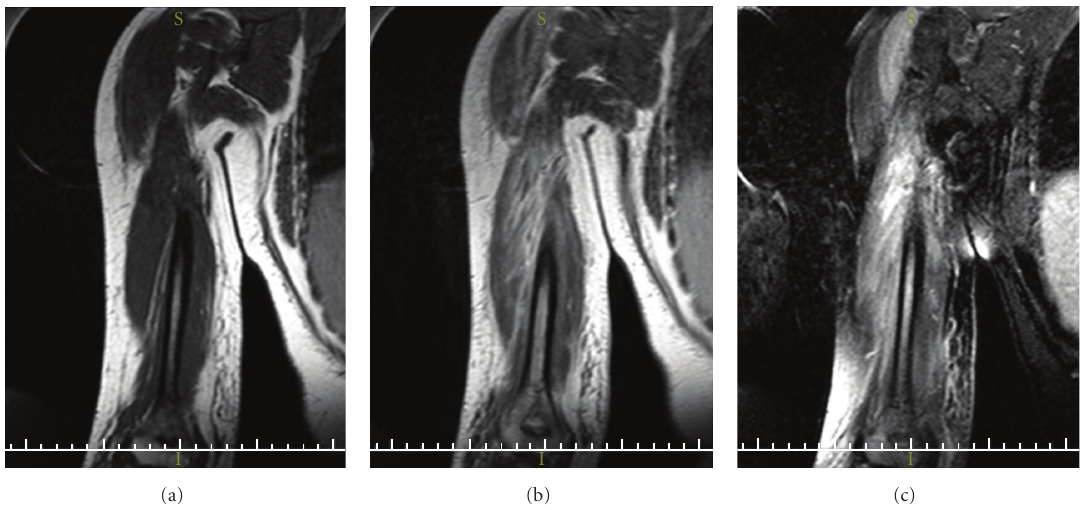
Figure 1: Coronal MRI showing areas of abnormal signal intensity at the inferior aspect of right deltoid muscle and the long and lateral heads of the triceps muscle (b). Please compare to the T1 image without contrast (a). (c) shows postgadolinium enhancement along-with fluid seen in subcutaneous tissue along the lateral aspect of distal right arm. Table 1: Reports of Sickle Cell Myonecrosis in medical